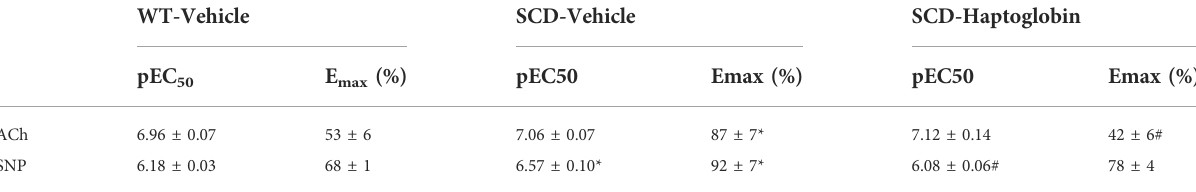
TABLE 1 Potency (pEC 50 ) and maximal responses (E max ) values obtained from concentration-response curves in cavernosal strips from WT and SCD mice treated with vehicle or